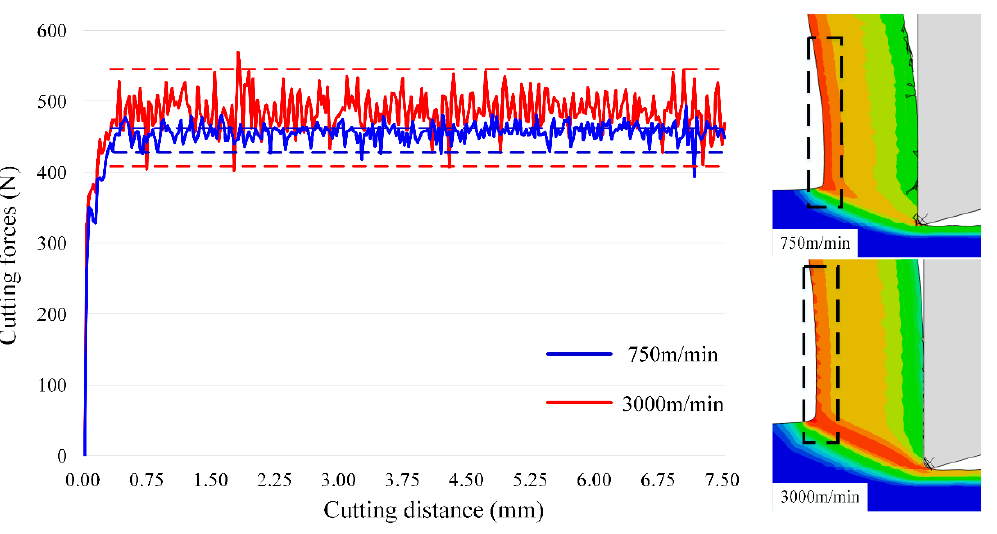
Figure 9. The distribution of the dislocation density at different cutting speeds, ( a ) 750 m/min, ( b ) 1500 m/min, ( c ) 2250 m/min and ( d ) 3000 m/min, area in the black rectangle show the distribution of the dislocation density in free surface of chips.